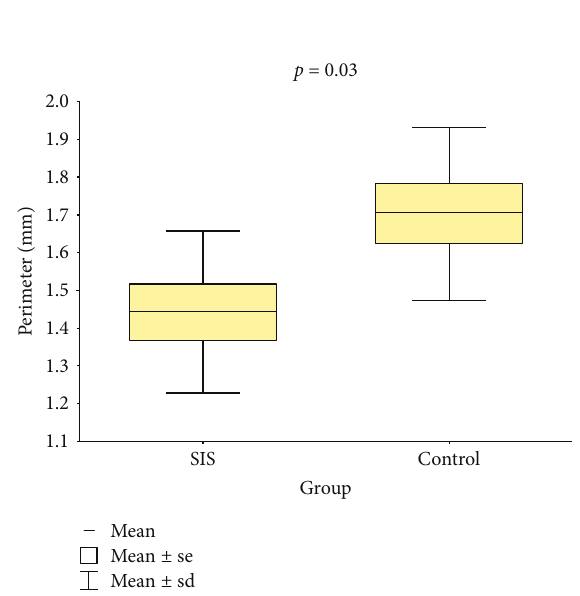
Figure 7: Tracheal defect perimeters of the groups.